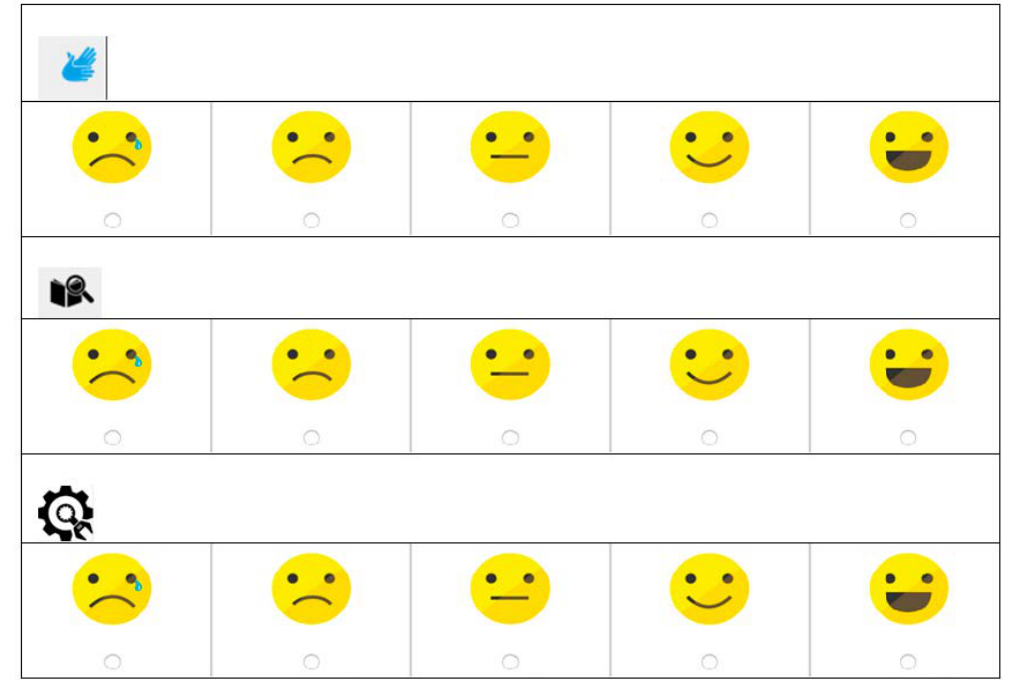
Figure 15. Deaf accessibility tools subjective evaluation sheet.